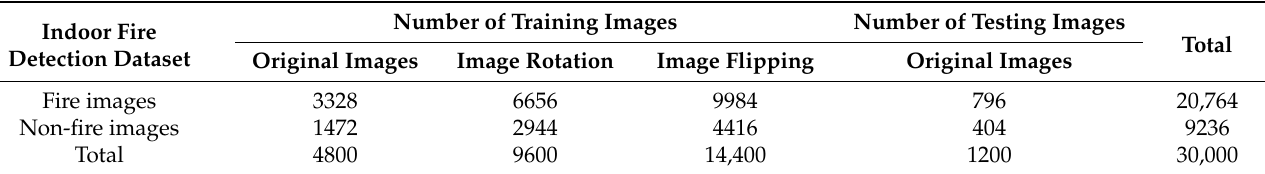
Table 2. Distribution of training and testing images in the indoor fire detection